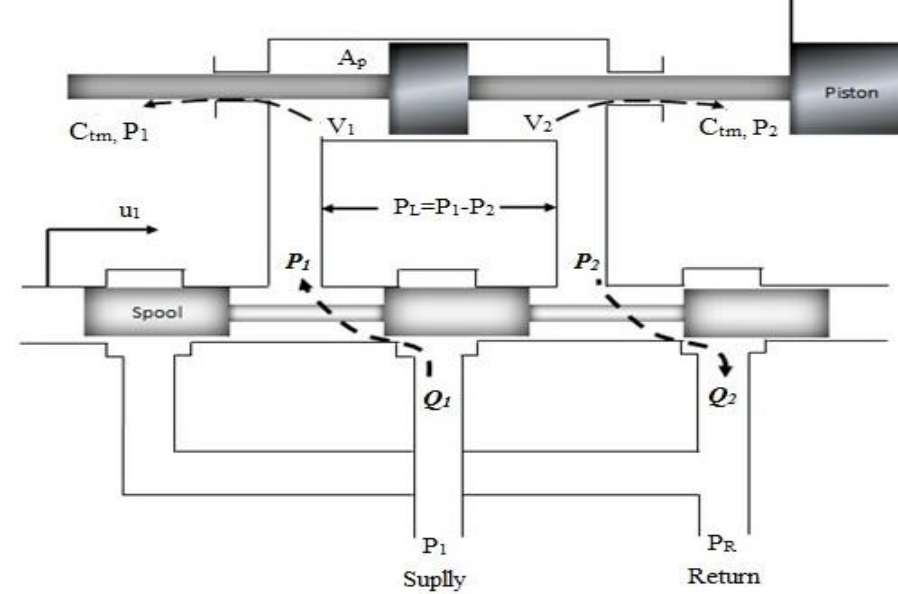
Figure 1. Physical schematic and variables for the hydraulic